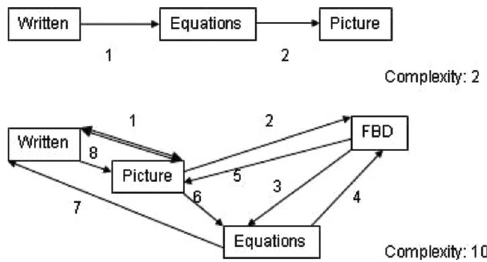
FIG. 7. Sequence diagrams showing the order in which students used representations in two of their problem solutions. Above: A novice’s correct solution to the first of the electrostatics problems. Below: A solution where a novice student did not reach the correct answer. The complexity parameter is defined in the text.